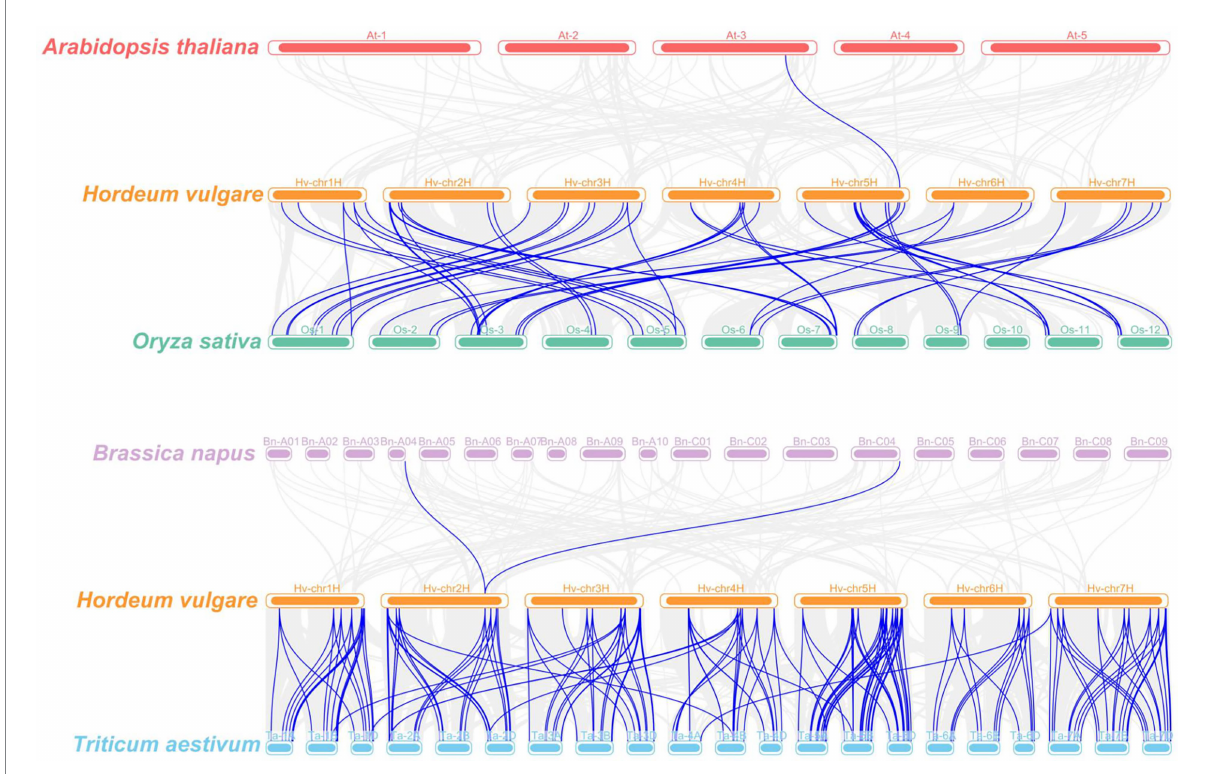
FIGURE 5 Synteny analyses of CaMs/CMLs between barley and four plant species ( Arabidopsis thaliana , Oryza sativa , Brassica napus , and Triticum aestivum ). Gray lines indicated collinear blocks and blue lines highlighted syntenic CaMs/CMLs gene